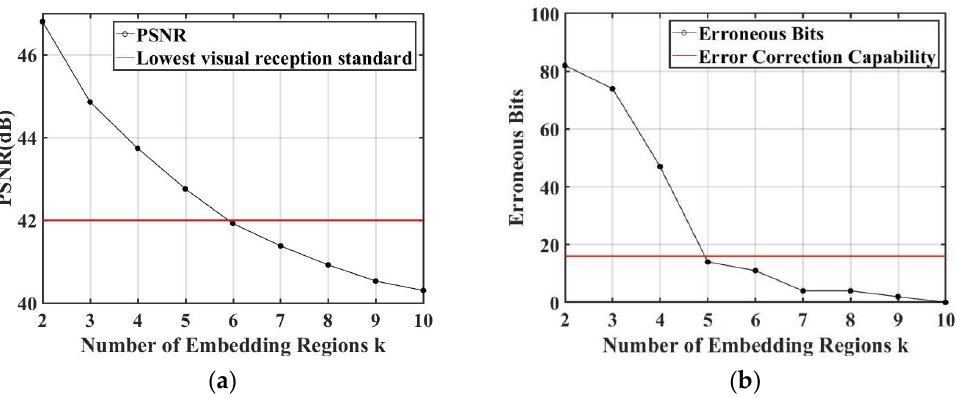
Figure 10. The effect of different numbers of embedded regions k: ( a ) PSNR with different numbers of embedding regions; ( b ) BERs with different numbers of embedding regions.